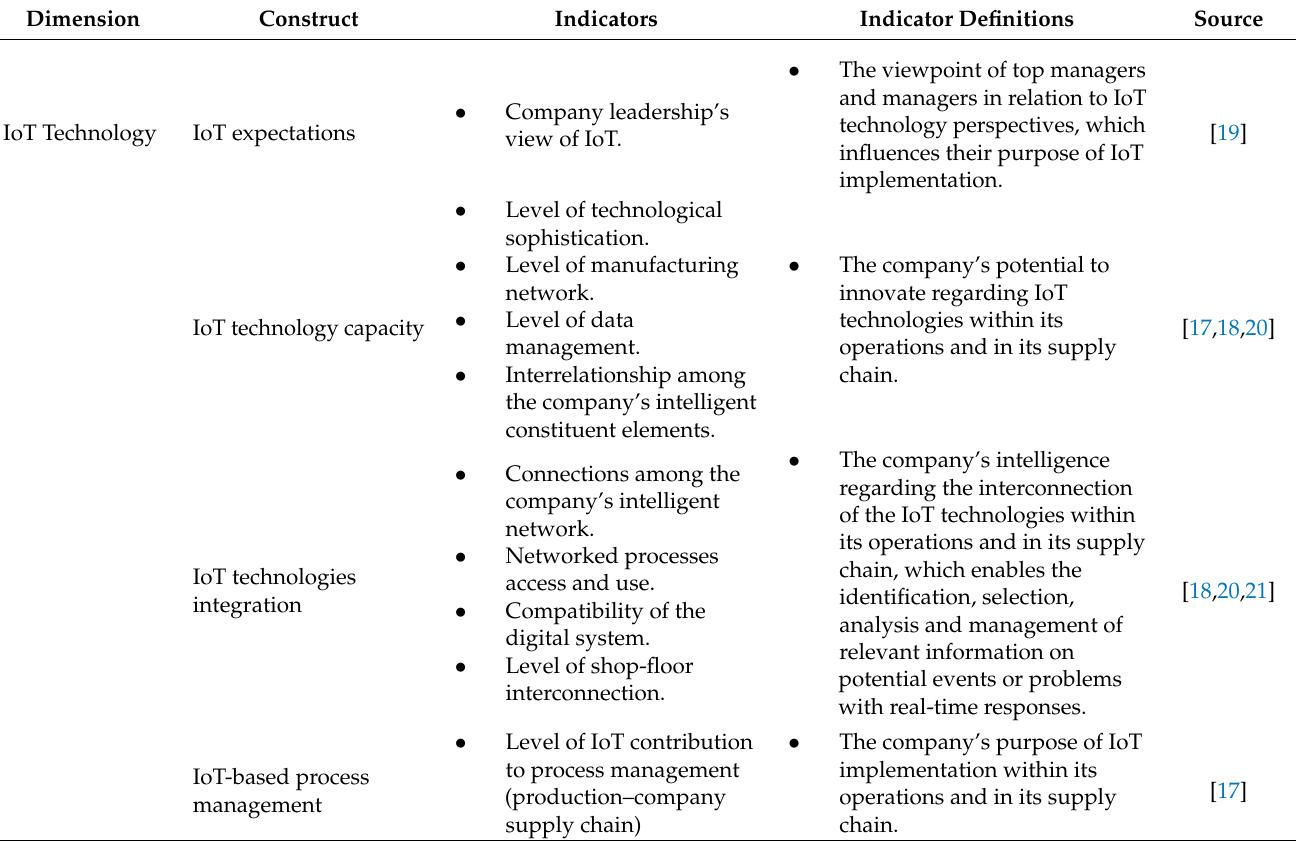
Figure 3. The synthesis of the statements and their dimensions, constructs and factors. Table 1. IoT